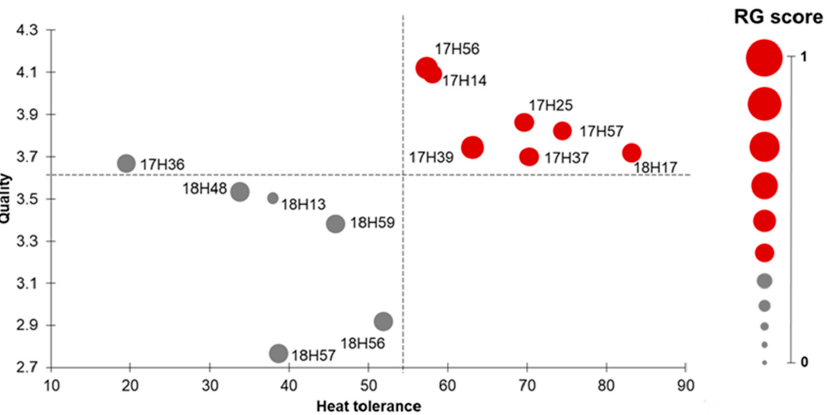
Figure 4. Scatter plot of hybrid scores considering the quality, heat tolerance and resistance genes of the 13 F 1 hybrids by conferring an arbitrary score for each phenotypic trait reported. Dashed lines represented the mean threshold for each trait. The red spots represented the acceptable Scale for the RG score.